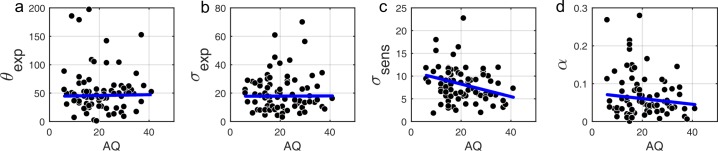
Correlations between AQ scores and BAYES model parameters.(a) θexp - mean of the prior expectations (r = 0.031, p=0.820), (b) σexp - uncertainty of the prior distribution (r = 0.018, p=0.962), (c) σsens - uncertainty in the sensory likelihood (r = −0.185, p=0.011) and (d) α - fraction of random estimations (r = −0.135, p=0.238). The blue lines are robust regression slopes.10.7554/eLife.34115.011Figure 7—source data 1.This zip archive contains .csv files with all of the data that was used to produce plots in Figure 7.BayesEstimatedParams.csv contains BAYES model parameter estimates. Traits.csv contains AQ scores of each individual (column 3) as well as all other traits. SourceData_Readme.txt contains more detailed description of each data file. The plots were produced with MATLAB script analyze_params.m which is available in the provided Source code 1. The SourceCode_Readme.txt contains more detailed description of the source code.